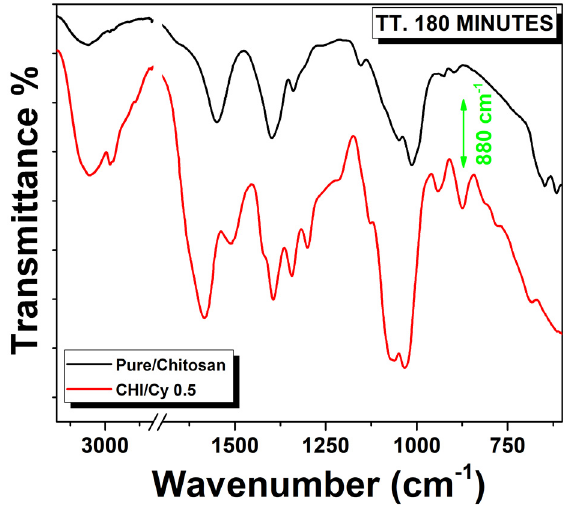
Figure 4. FTIR spectra of Cu-based alloy coated with a thin film of prepared chitosan film by GDL and film CHI-Cy 0.5 processed for 180 min, black and red line, respectively.